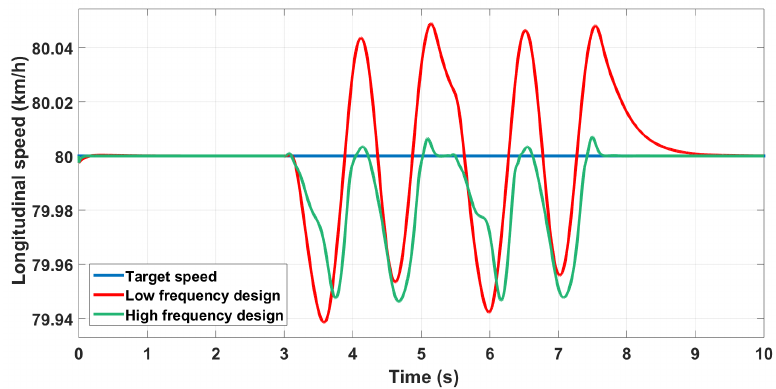
Figure 18. Longitudinal velocity control with different crossover frequencies.